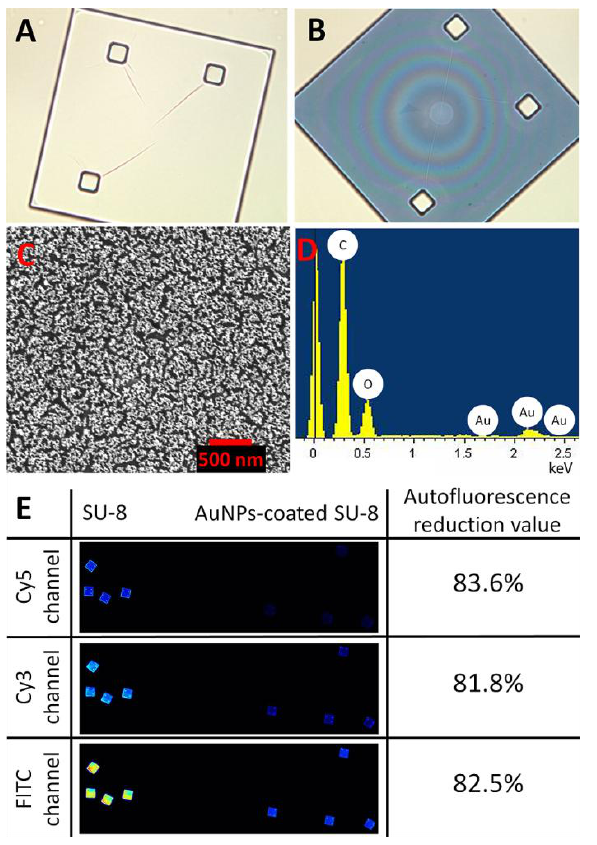
Figure 1. Optical images of a SU-8 microparticle before ( A ) and after ( B ) deposition of the AuNPs (at 200× magnification). ( C ) Surface characterization of a Au-coated SU-8 microparticle by scanning electron microscopy (SEM) and ( D ) energy-dispersive spectroscopy (EDS-SEM) demonstrating the Au layer deposited on the SU-8 surface. ( E ) shows reduction in autofluorescence of the Au-coated SU-8 surface for the different wavelength ranges: Cy3, Cy5 and